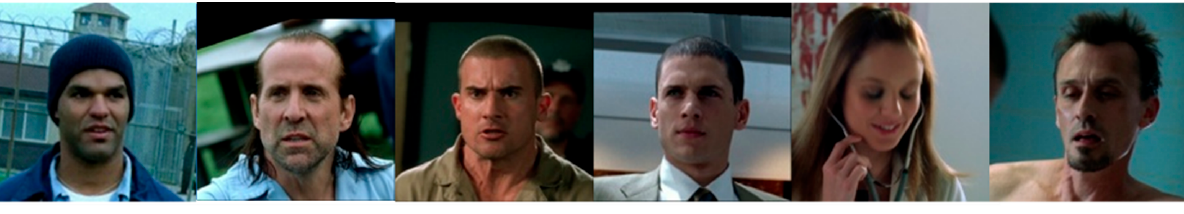
Figure 4. Samples from ICT-PB [52].